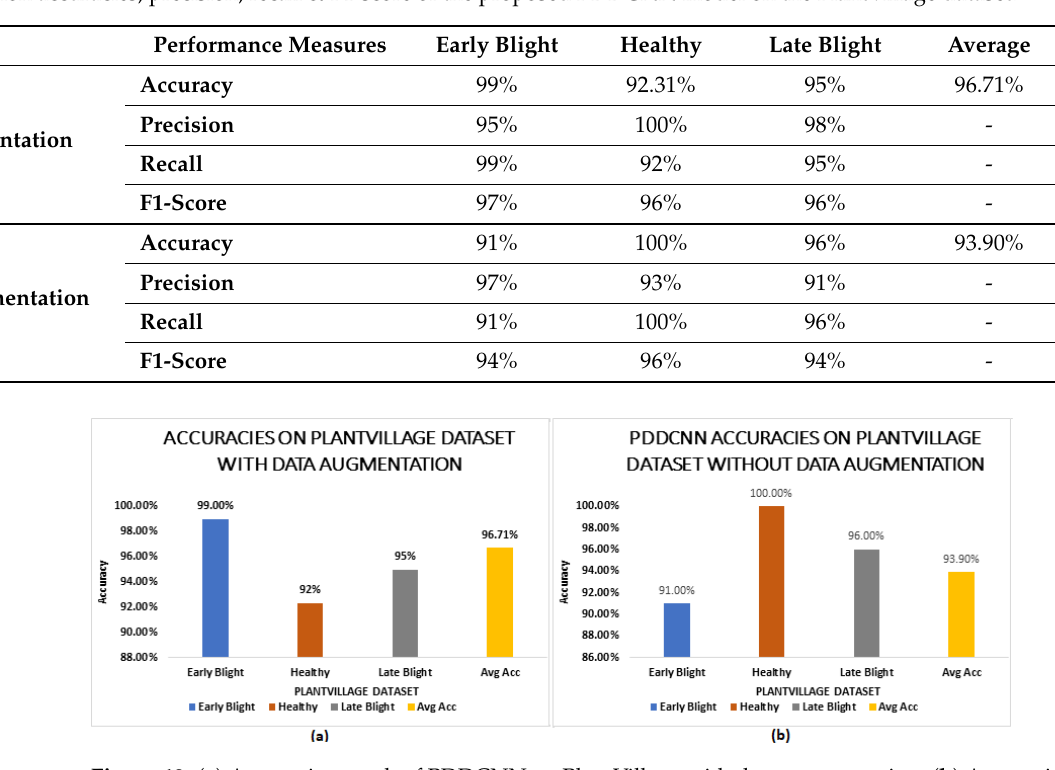
Figure 12. ( a ) Accuracies graph of PDDCNN on PlantVillage with data augmentation. ( b ) Accuracies graph of PDDCNN on PlantVillage without data